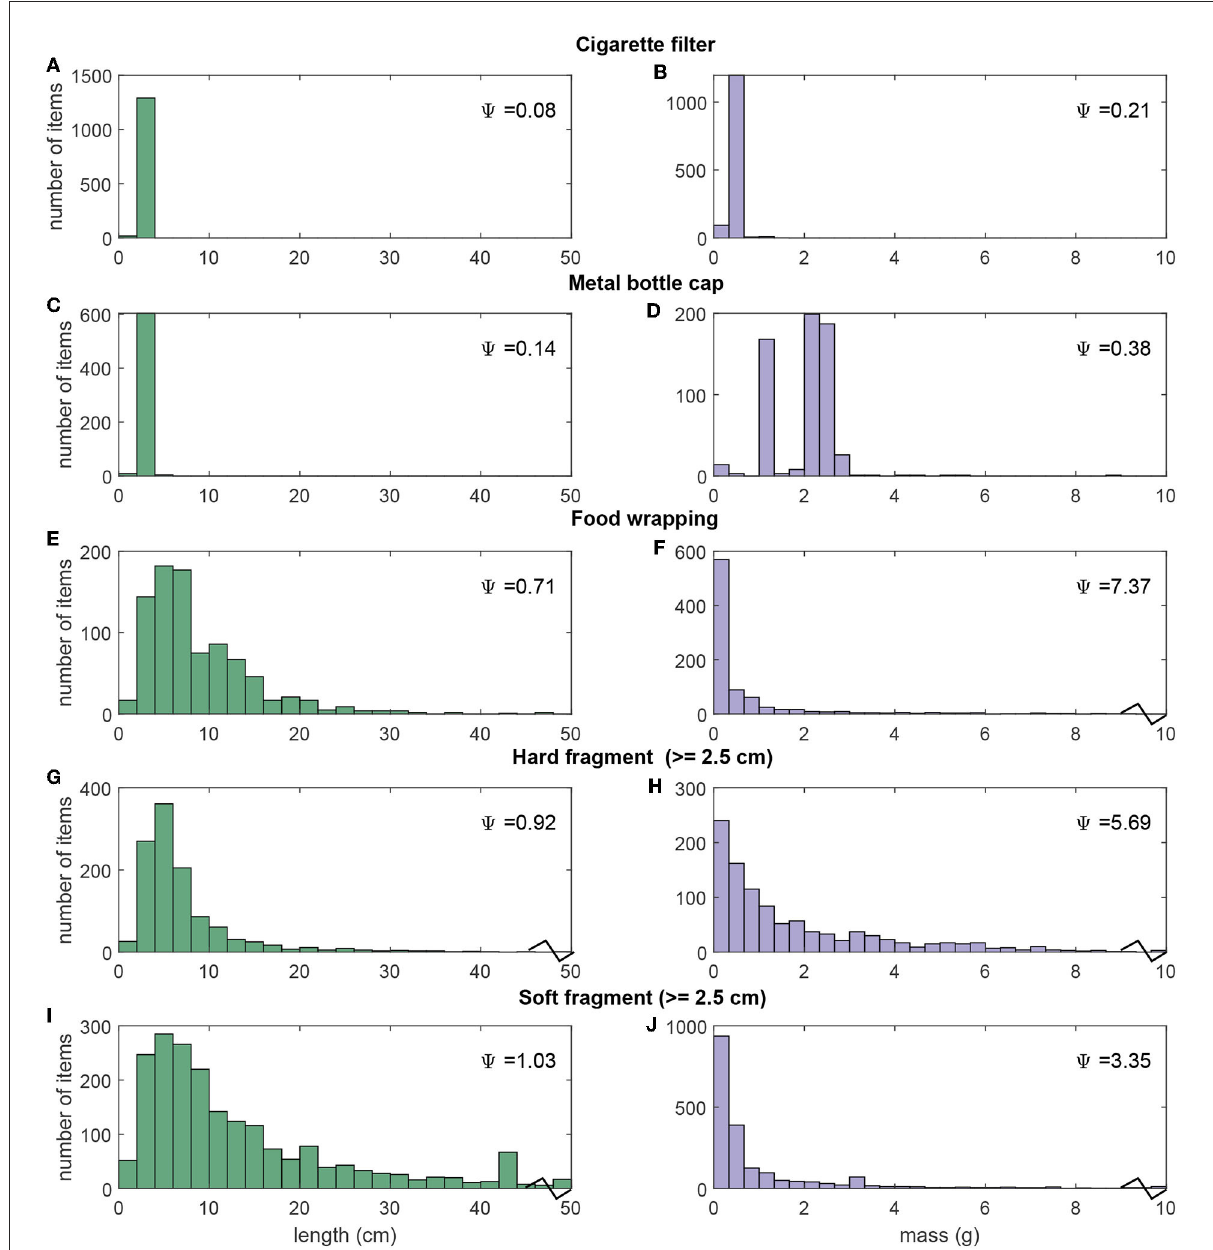
FIGURE4 (A–J) Length (left column, green) and mass (right column, purple) distribution of the five most commonly found items, and their corresponding category heterogeneity Ψ . The scale break in the x-axis of panels indicate a wider histogram than inferred from the visible histogram.